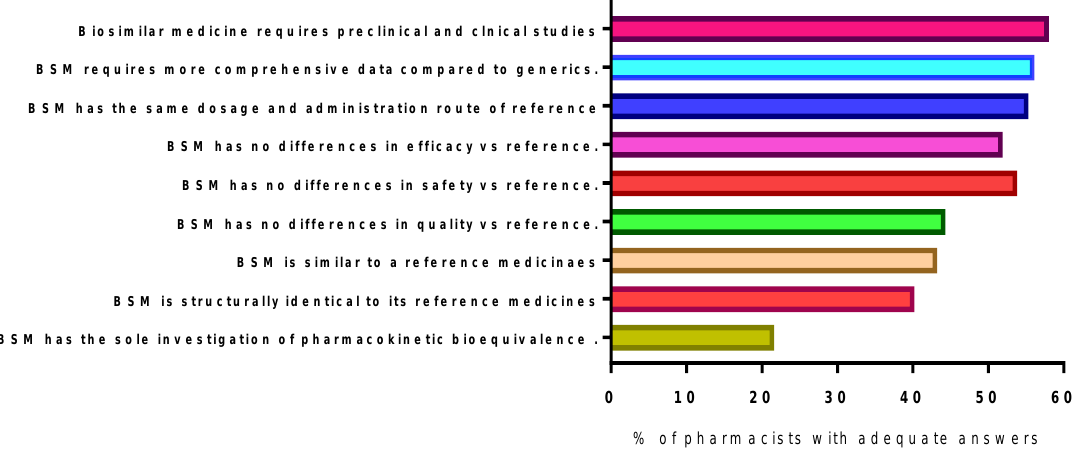
participants correctly answered five and four questions respectively. Only 14 (5.3%) had all wrong answers, while eight (3.0%) had all nine correct answers (Table 3).